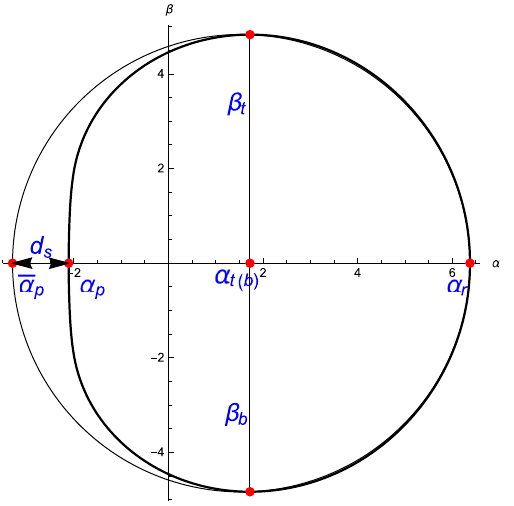
Fig. 16 The black hole shadow and reference circle. ds is the distance between the left points of the shadow and the reference